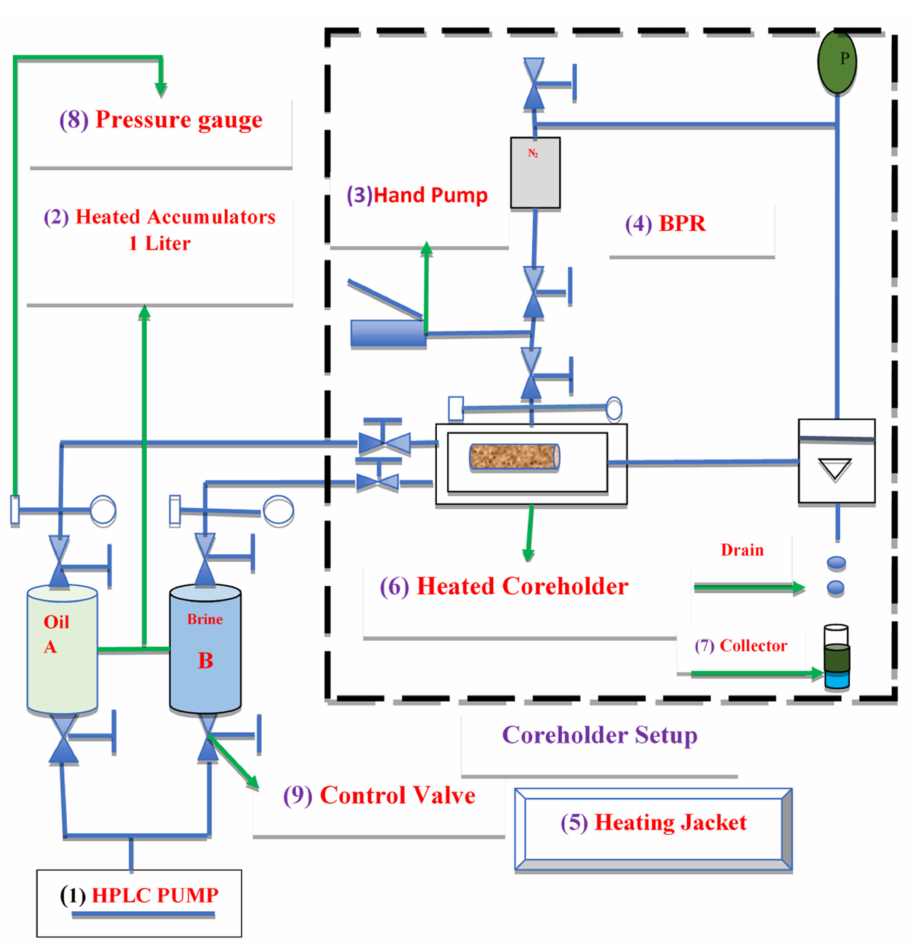
Figure 6. Schematic diagram of the core flood